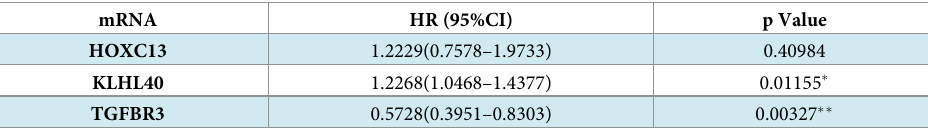
Table 1. Result of multivariate Cox regression.